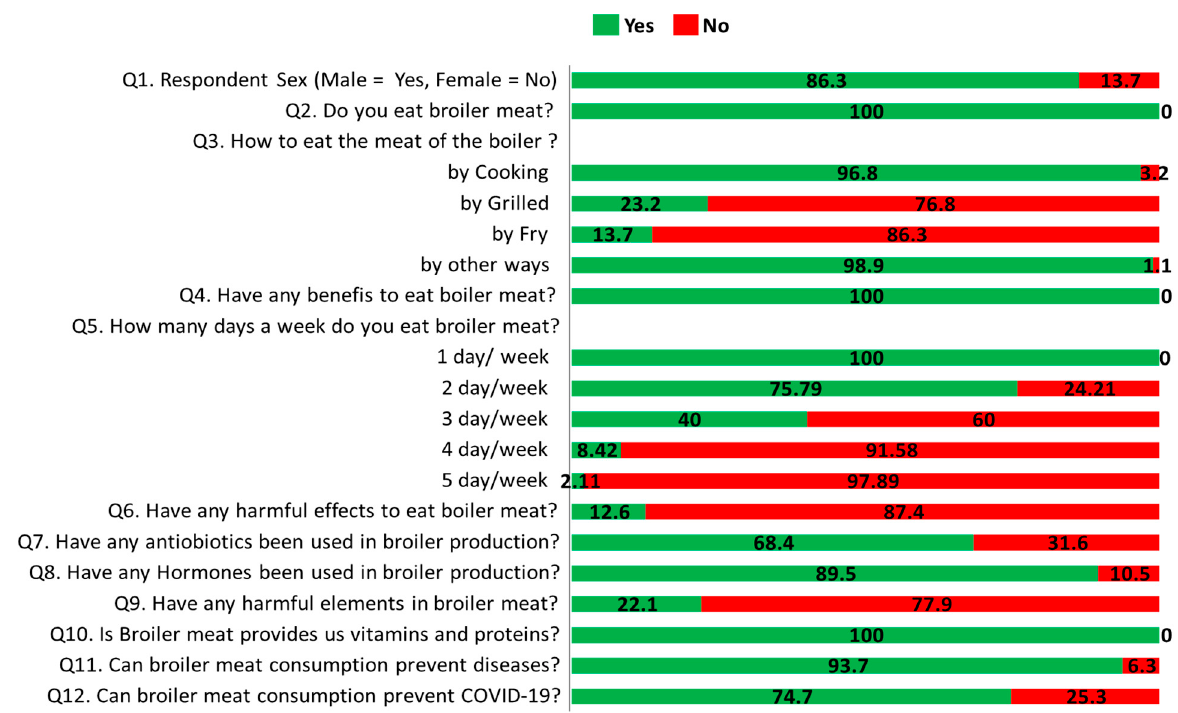
Figure 1. Chart showing the percentages of the responses regarding the attitude towards broiler consumption of consumers. The responses were recorded as Yes or No. Q1, question 1; Q2, question 2; Q3, question 3; Q4, question 4; Q5, question 5; Q6, question 6; Q7, question 7; Q8, question 8; Q9, question 9; Q10, question 10; Q11, question 11; Q12, question 12. Table 1. Overall percentages of different antimicrobials residue in different parts of the broiler body.